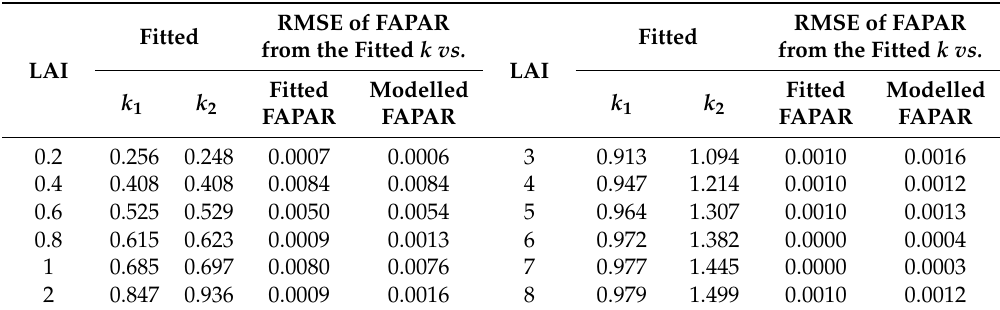
Table 3. Root mean squared error (RMSE) of estimating FAPAR from the fitted k 1 and k 2 given VIS = 30 km. RMSE of FAPAR Fitted from the Fitted k vs. LAI